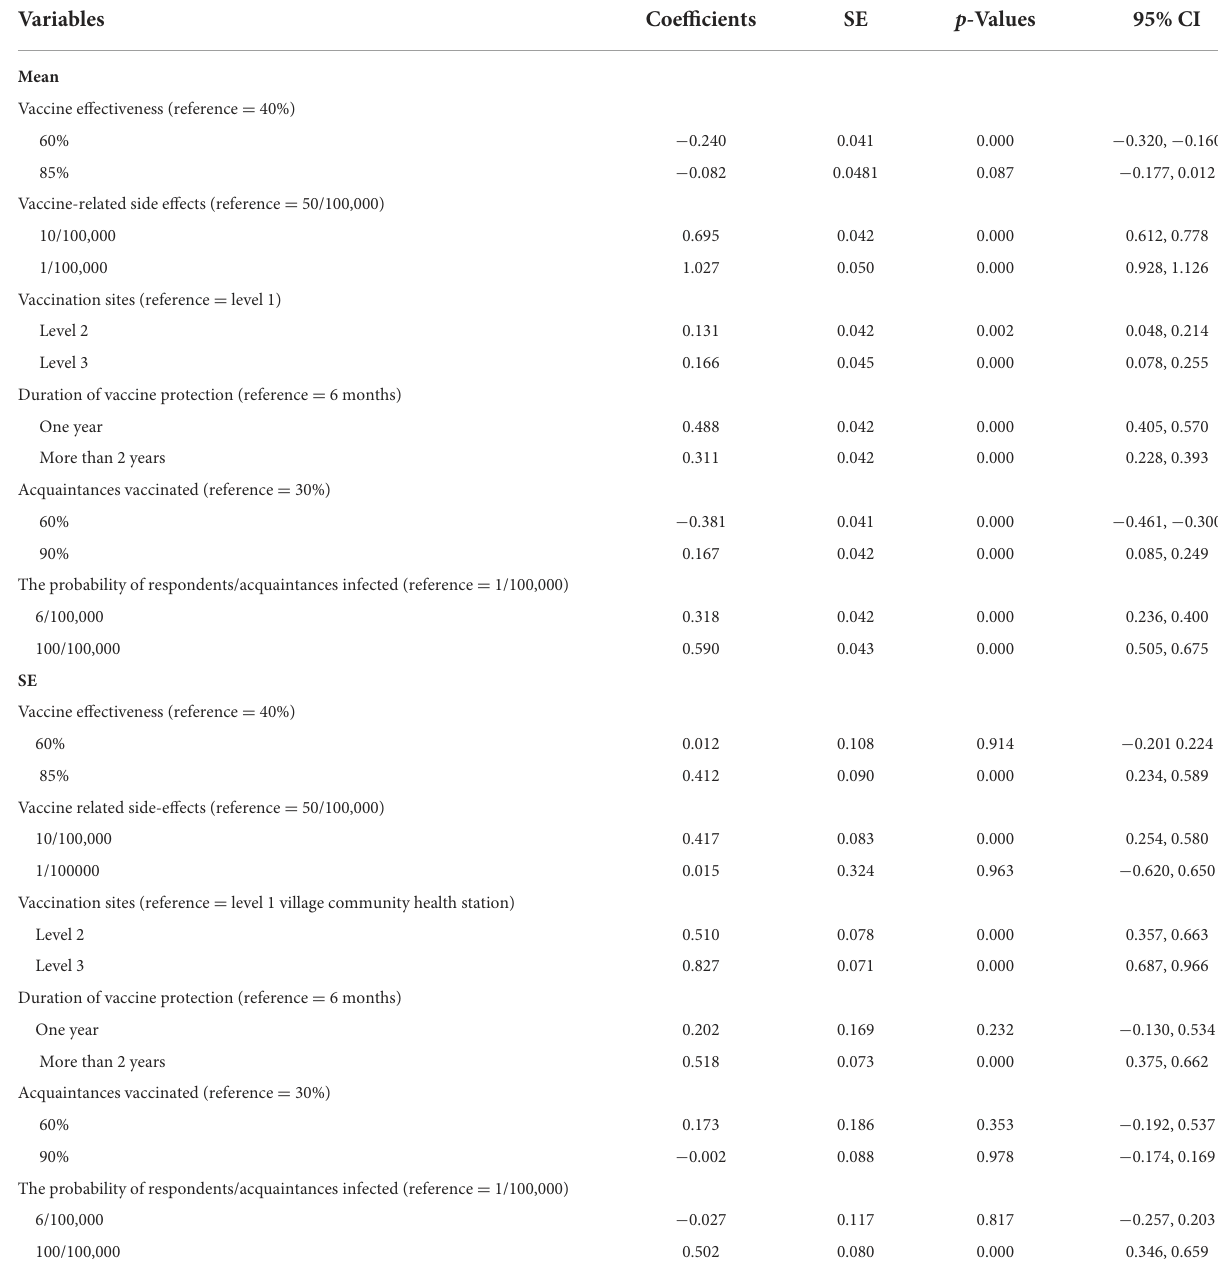
TABLE 5 Mixed logistic regression models of student